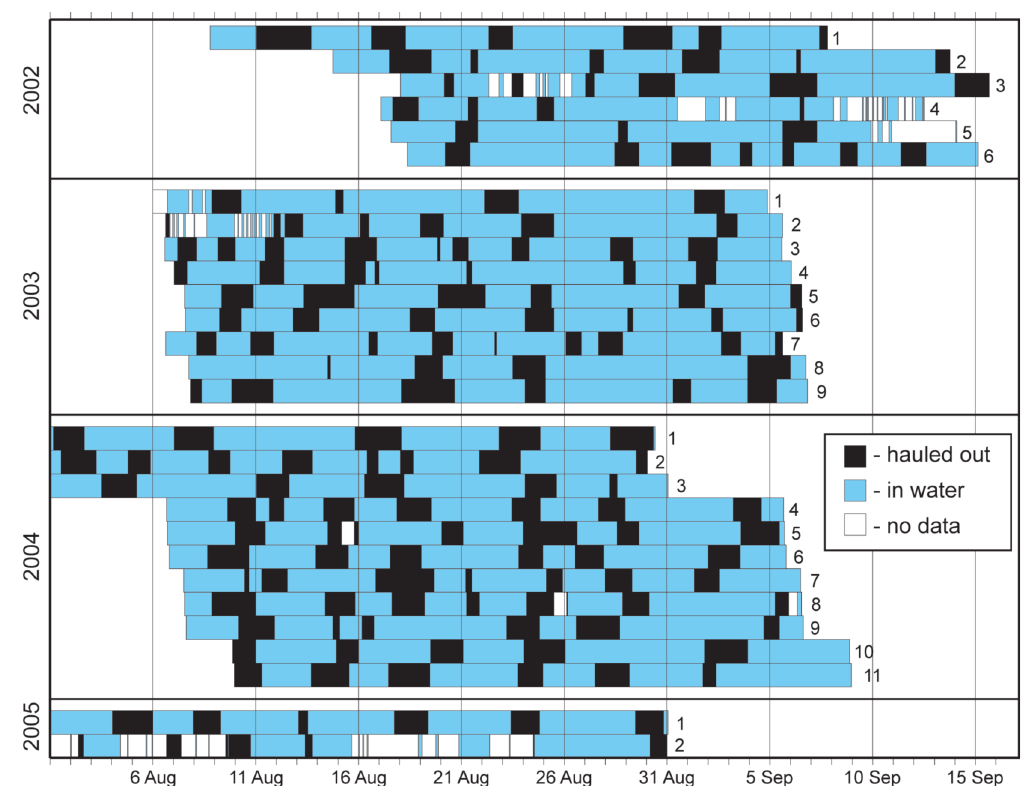
Fig 6. Haul-out chronologies for 28 walrus data sets from 2002–2005 based on information from satellite relayed data loggers (SRDLs) deployed on the tusks of the animals. Haul-out information from the first 30 days of deployment, starting 24 h post-handling, was included in this study in addition to haul-out data from the 30 first days of August for SRDLs that trans- mitted for more than one year (walrus 1, 2 and 3 in 2004, and 1 and 2 in 2005). The figure illustrates that individual walruses, within years, tend to be hauled-out (and thus also at-sea) at the same time and more frequently than at random. (From Lydersen et al.